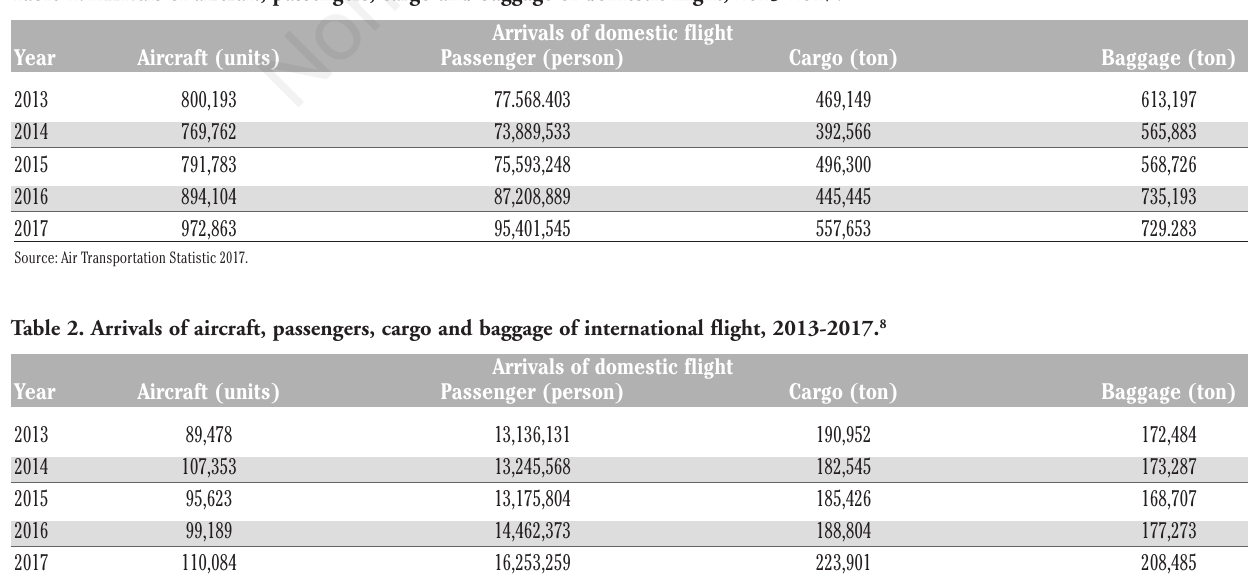
Table 1. Arrivals of aircraft, passengers, cargo and baggage of domestic flight, 2013-2017. 8 Year Aircraft (units)